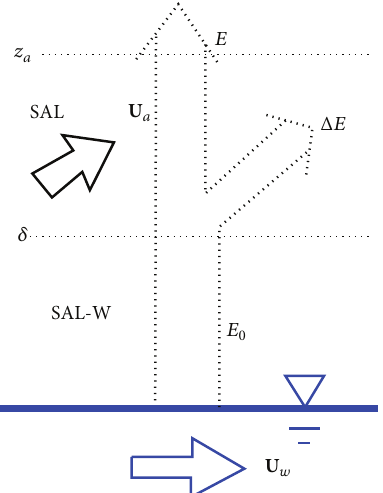
Figure 2: Schematic diagram of the double-deck surface air layer (DSAL) formed over the running water. See text for